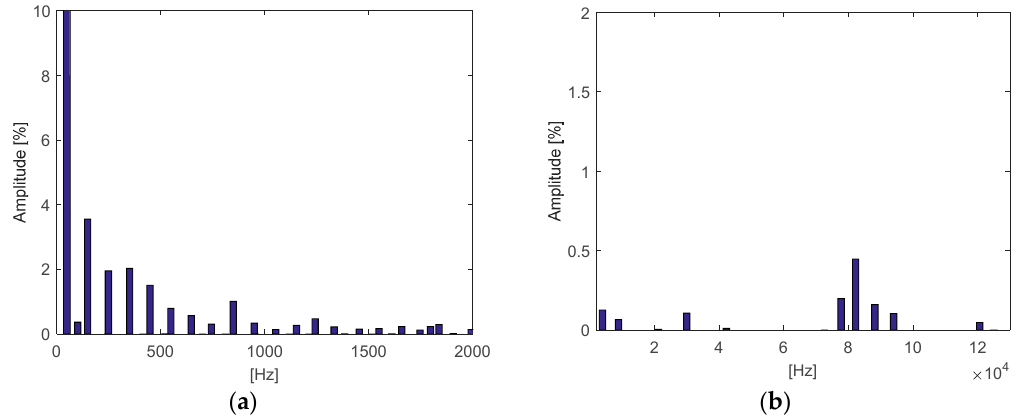
Figure 9. Case study 3: ( a ) Percentage low-frequency spectrum and ( b ) percentage high-frequency spectrum obtained through SWWMEM.